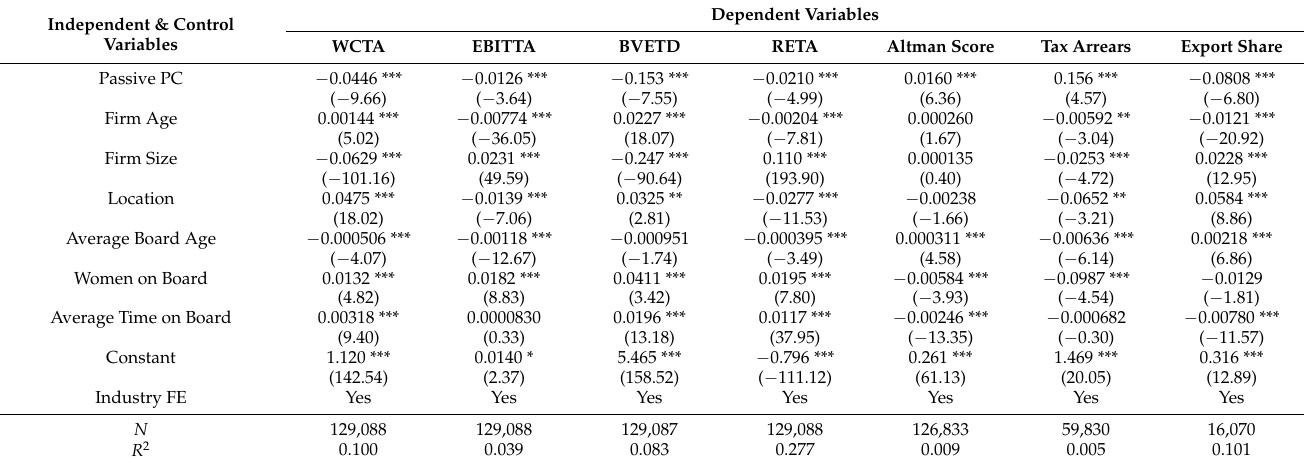
Table A1. OLS regressions with seven different dependent variables (year 2018) and Passive PC as the independent variable.